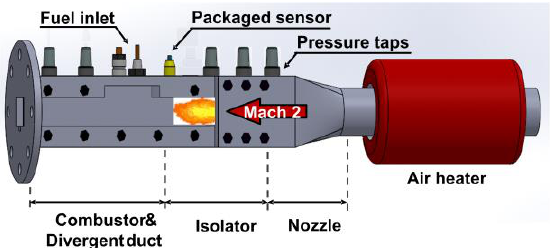
Figure 6. Schematic diagram of the main testing structure of a small-scale, high-unit Reynolds number, direct-impulse combustion tunnel facility.